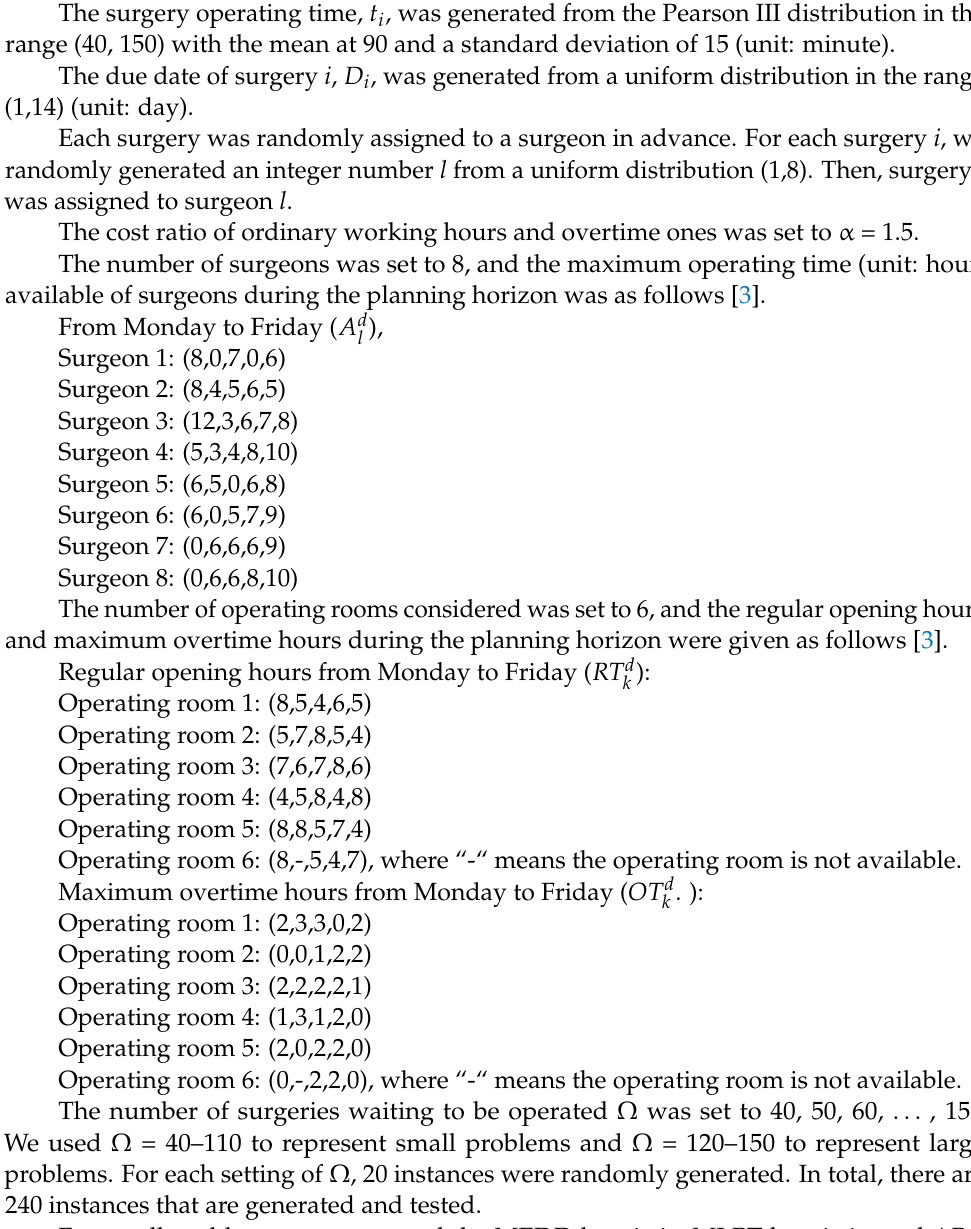
Algorithm development environment: Microsoft Visual C + + 2019. Software for running the MIP model: AMPL with CPLEX 11.2